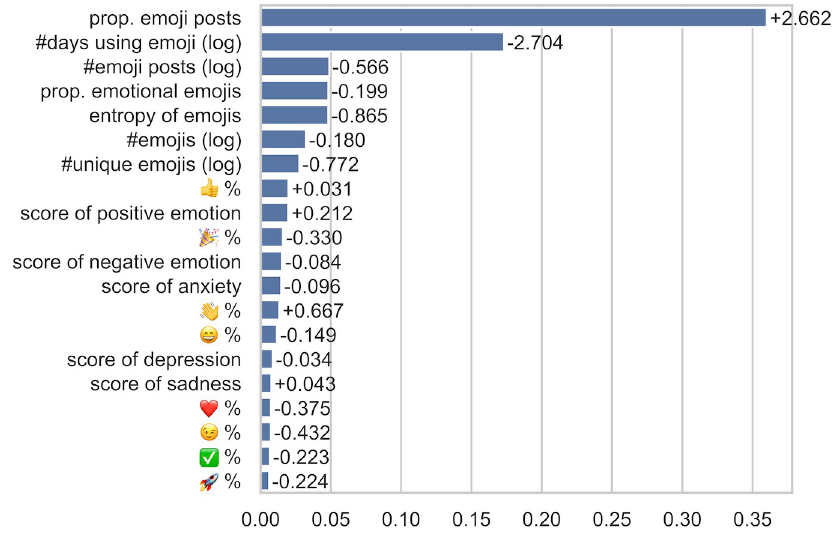
Fig 5. Importance of top features (10% active users by avg . working hours). Proportion of emoji posts, emotional scores, and affection-related emojis are important predictors. Bars: importance scores from GBDT; signed values: coefficients from Logistic